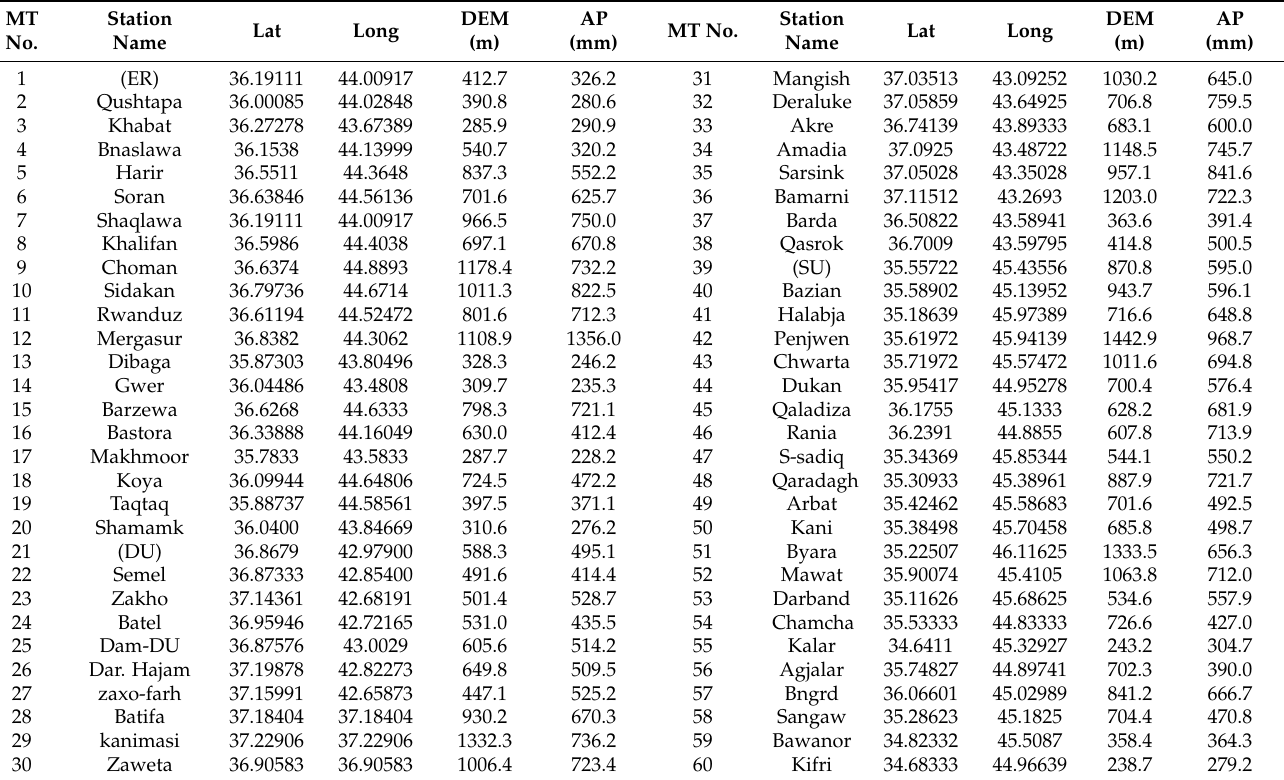
Table 1. The (AP) annual precipitation (mm), elevation, and coordinates of the 60 (MT) meteorological stations in the KRI used in this